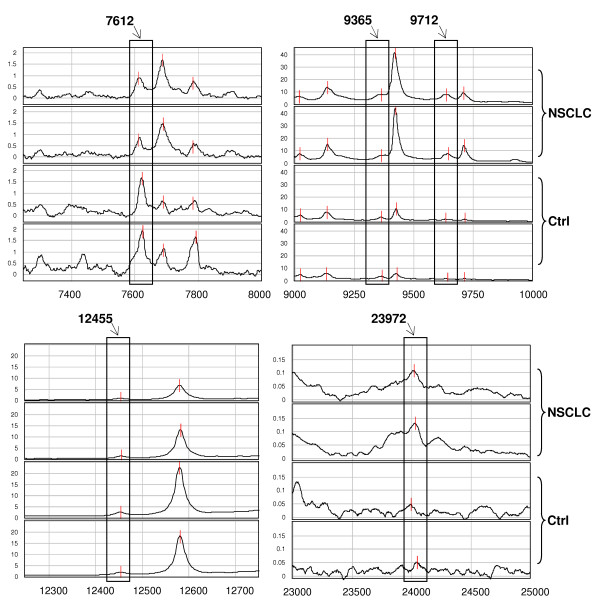
Serum protein profile of low-MW predictor peaks (H50). Representative spectra (in duplicate) obtained by SELDI-ToF-MS analysis concerning the 5 statistically significant peaks detected with H50 ProteinChip Array and used as predictors to build the decision classification tree shown in Figure 4. The peaks of interest are highlighted in rectangles and their m/z values are reported above. (Ctrl = control subjects).